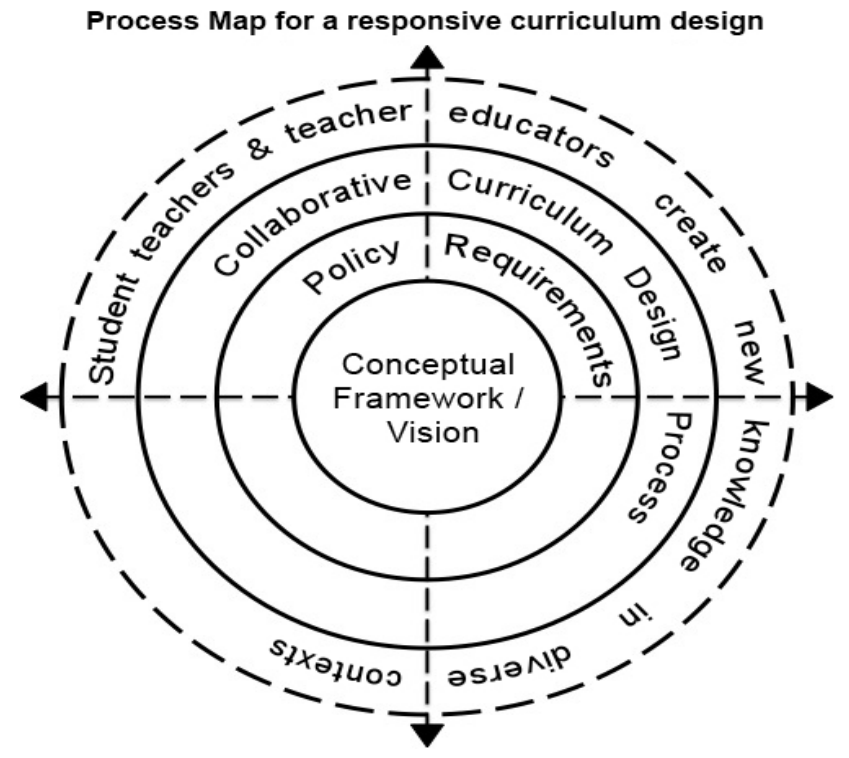
Figure 2. A possible process map for curriculum design in teacher